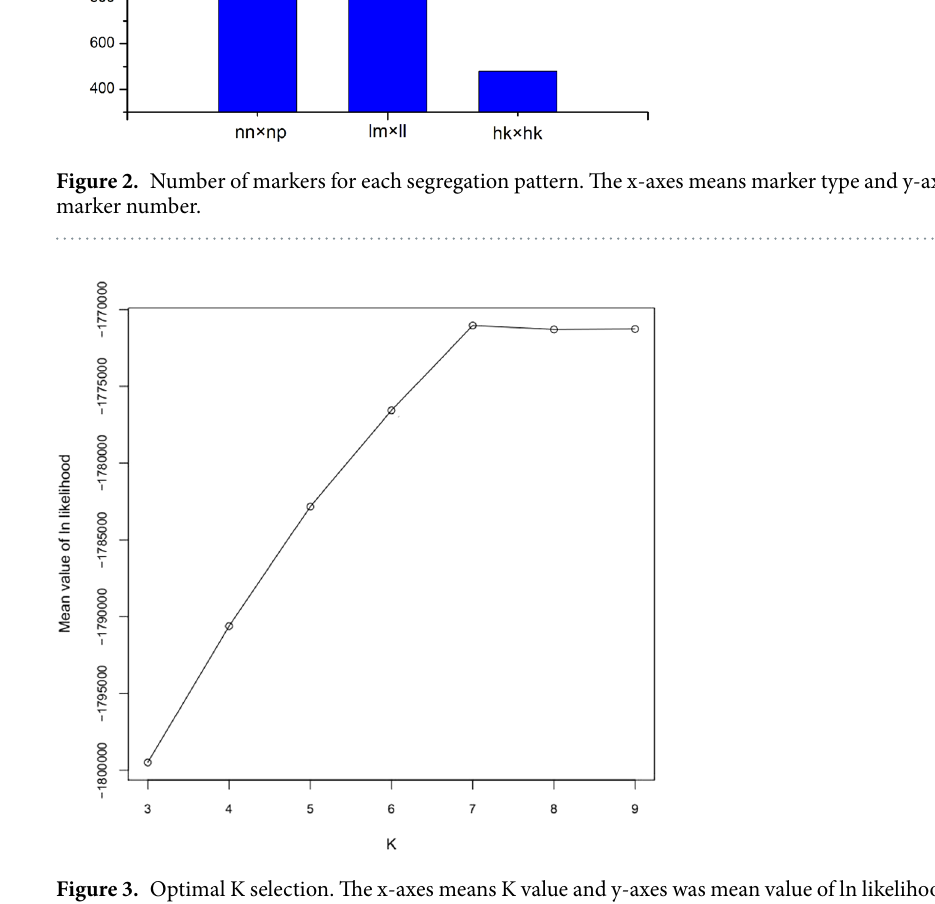
Figure 3. Optimal K selection. The x-axes means K value and y-axes was mean value of ln likelihood respond to K